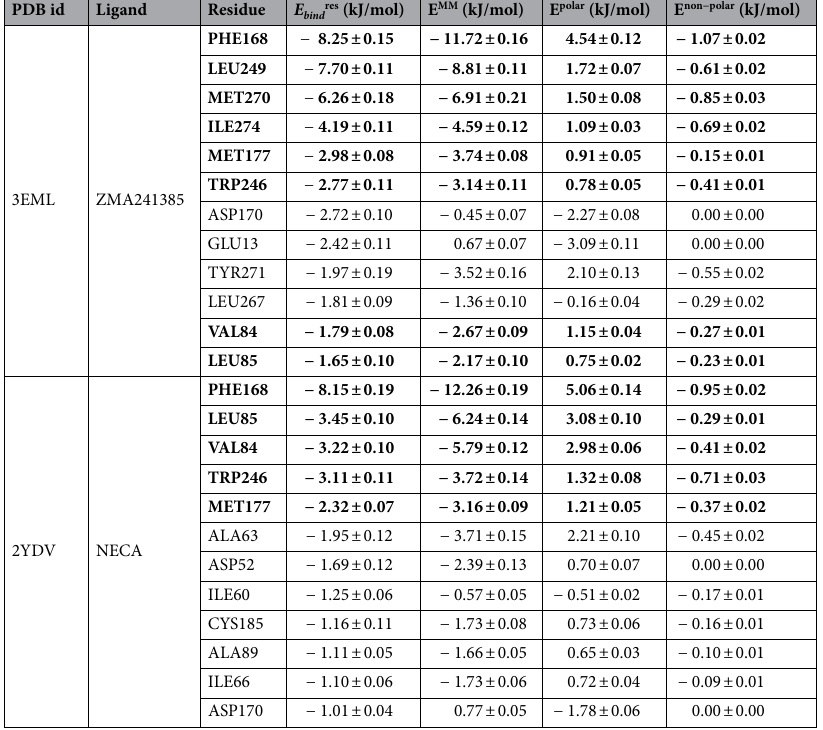
Table 4. Top 12 residues of the A2A AR those contributed to the total ligand binding energies ( E bind total ) by < − 1 . 00 kJ/mol. Decomposition of the residue-wise contributions ( E bind res ) into the molecular mechanics net non-bonded interaction energies ( E MM ), polar solvation energies ( E polar ) and, non-polar solvation energies ( E non−polar ) are summarized. Residues within 5 Å of the ligands ZMA241385 and NECA in the binding pocket of the crystal structure of the A2A AR-ligand complex (PDB ids: 3EML and 2YDV, respectively) and that contributed favorably to the binding energies of both the ligands by < − 1 . 00 kJ/mol are shown in